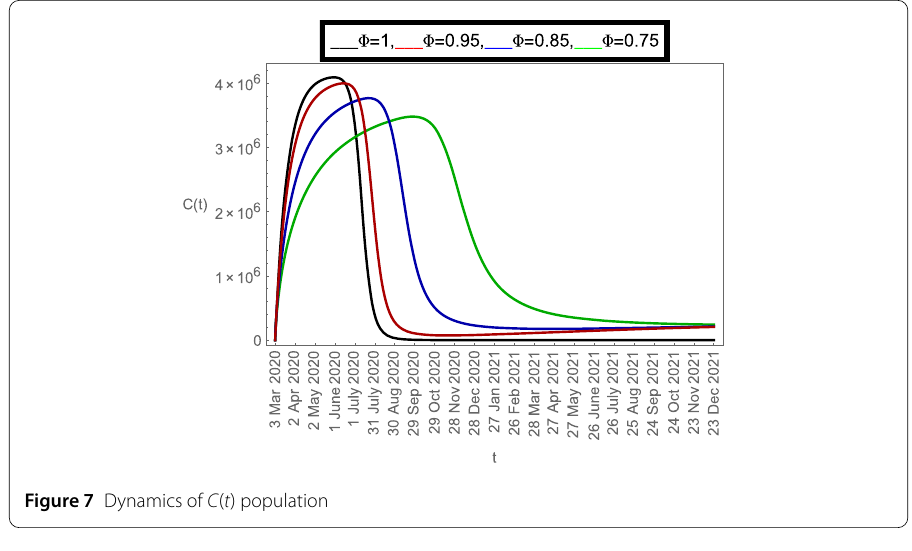
Figure 7 Dynamics of C ( t ) population